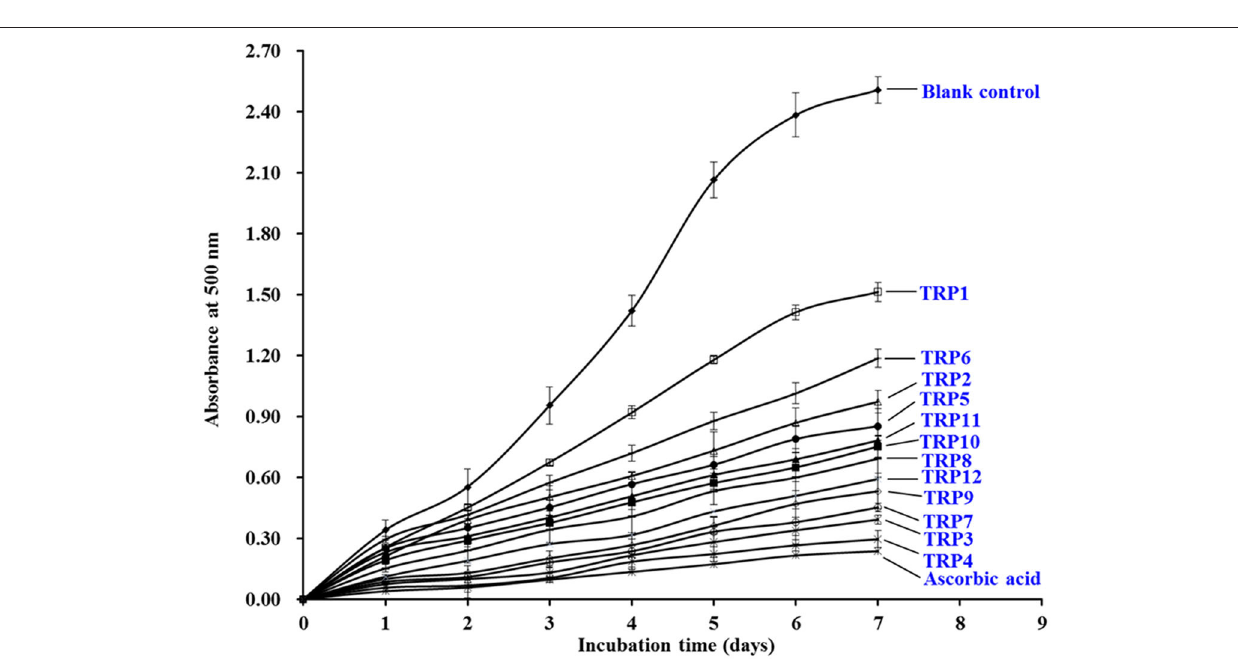
TRP6 might have weak cytotoxic effect on Chang live cells. In contrast, the TRP6 group (108.94% ± 1.38%) showed the highest cell viability among all groups ( p < 0.001). The result indicated